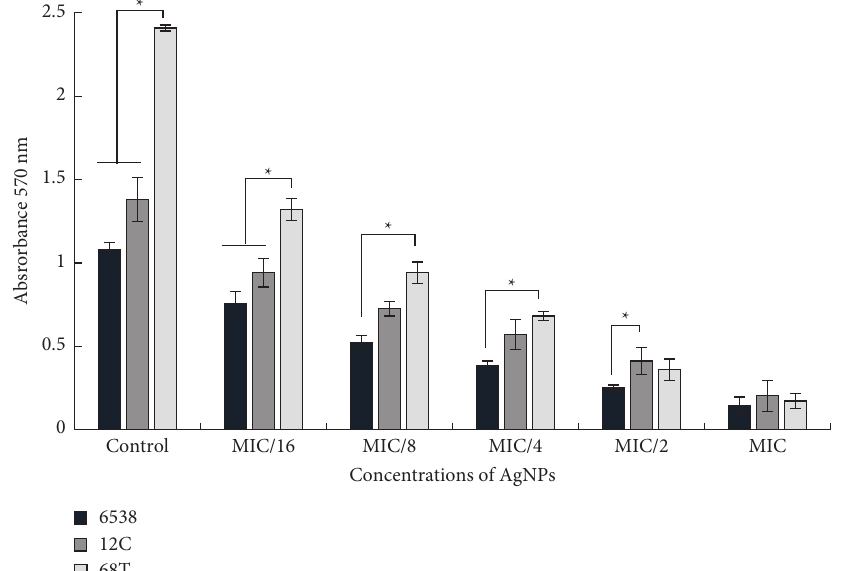
Figure 6: Evaluation of antiattachment effects of subinhibitory concentrations of biosynthesized AgNPs against S. aureus 6538, S. aureus 12C, and S. aureus 68T strains. Shown is the absorbance (A570) of stained bacteria with the crystal violet method. Error bars represent standard deviations. ∗ Differences were considered significant at p < 0 . 05.